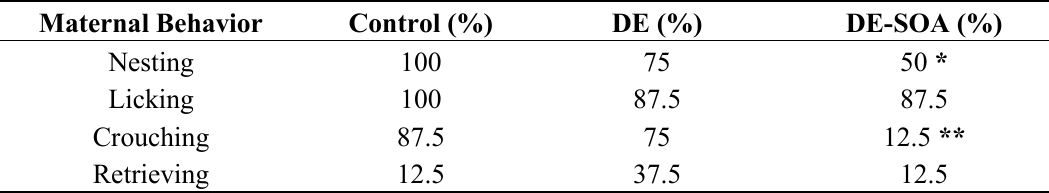
Table 2. Percentage of mice showing maternal behavior at PND 5. Maternal Behavior Control (%) DE (%) DE-SOA (%) Nesting 100 75 50 * Licking 100 87.5 87.5 Crouching 87.5 75 12.5 ** Retrieving 12.5 37.5 12.5